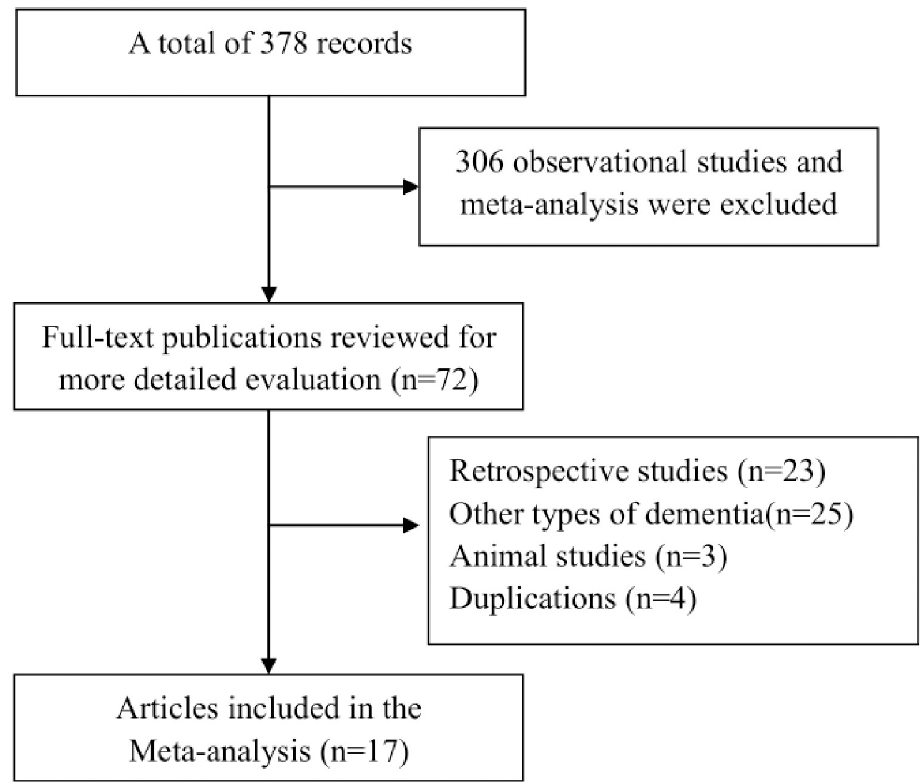
Fig 1. Flow chart of study selection